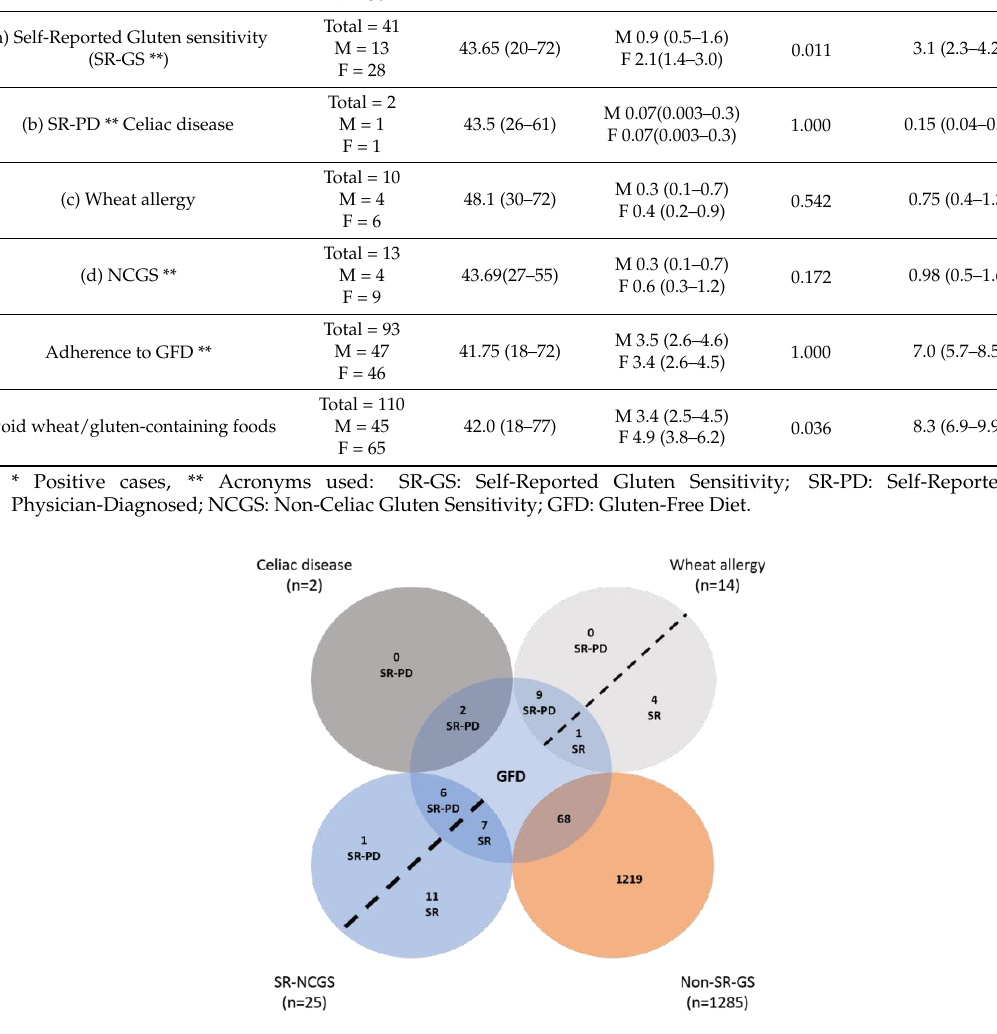
Figure 1. Characteristics of individuals following a GFD. Acronyms used: SR-PD: Self-Reported Physician-Diagnosed; SR: Self Reported; GFD: Gluten-free Diet; SR-NCGS: Self-Reported Non-Celiac Gluten Sensitivity; Non-SR-GS: Non Self-Reported Gluten Sensitivity.